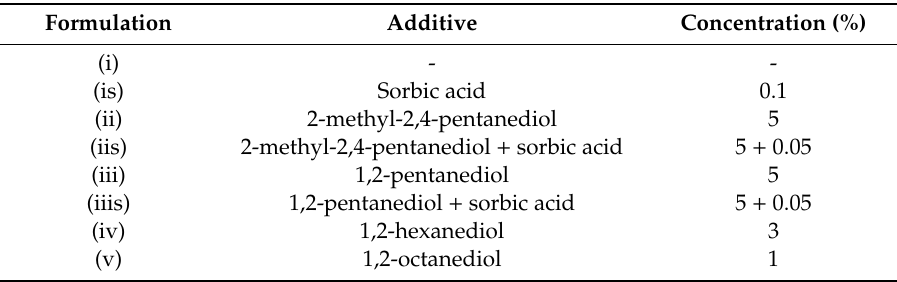
Table 1. Overview of test formulations.